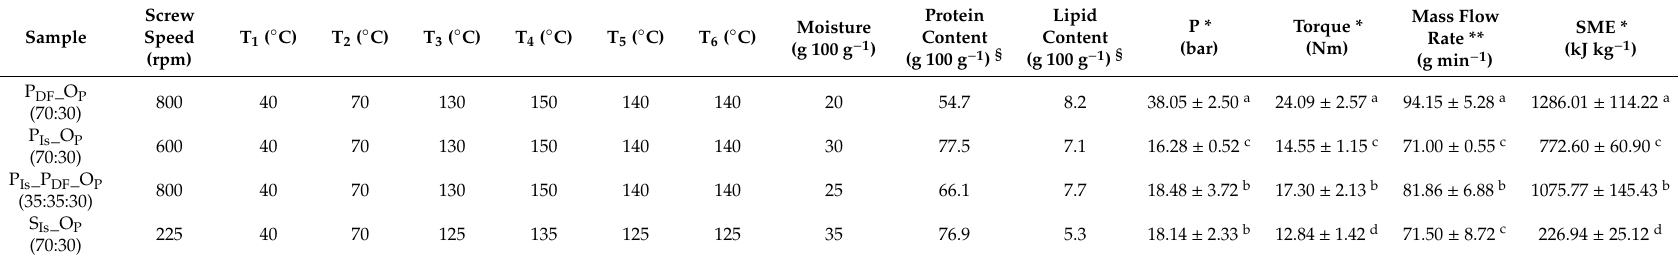
Di ff erent letters in the same column mean significant di ff erences at p < 0.05. § calculated from the protein content of the ingredients (Table 3). * data recorded within a minute, during the sample collection, with 60 measurements per minute (repeated for the two replicates of the process); ** n =